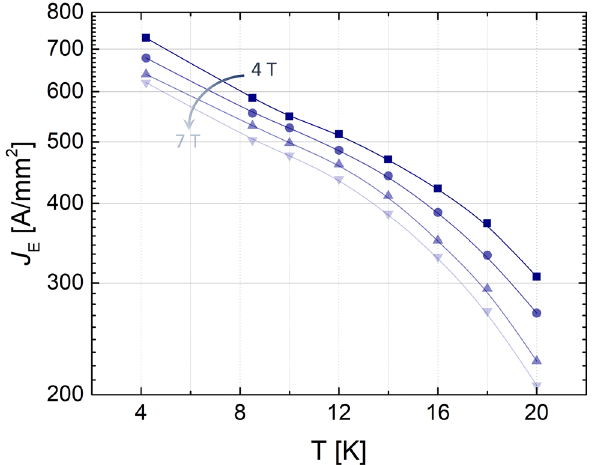
Figure 1. J E as a function of the temperature at different magnetic